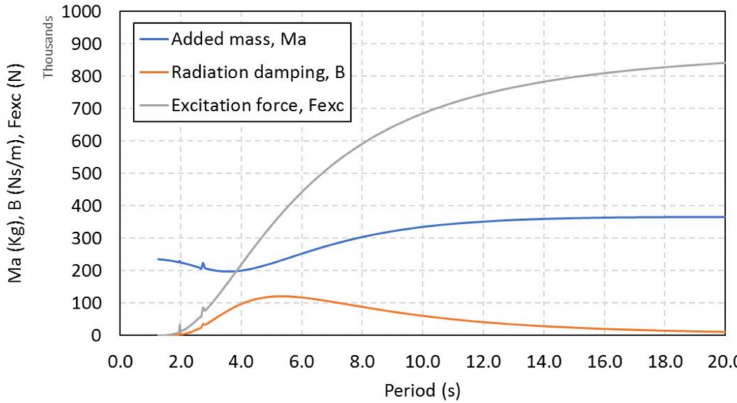
Figure 4. Frequency-dependent parameters of the heaving buoy WEC obtained from